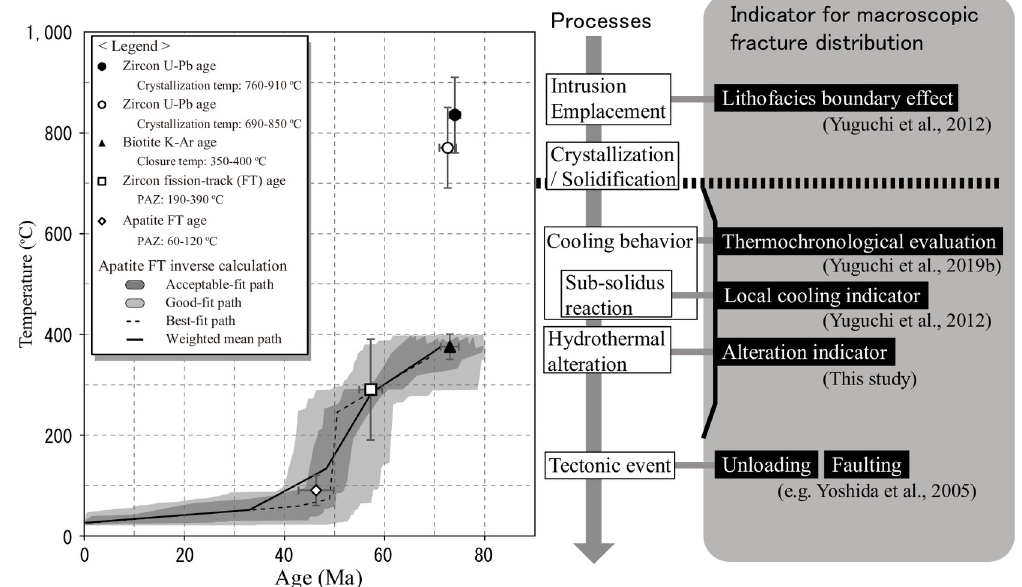
Fig 2. Time-temperature ( t-T ) paths of sample DH2 RA03 (–302.1 masl in borehole DH2) from the Toki granite [21], along with the intrinsic and extrinsic factors for an informative evaluation of the fracture population in a granite. PAZ indicates the partial annealing